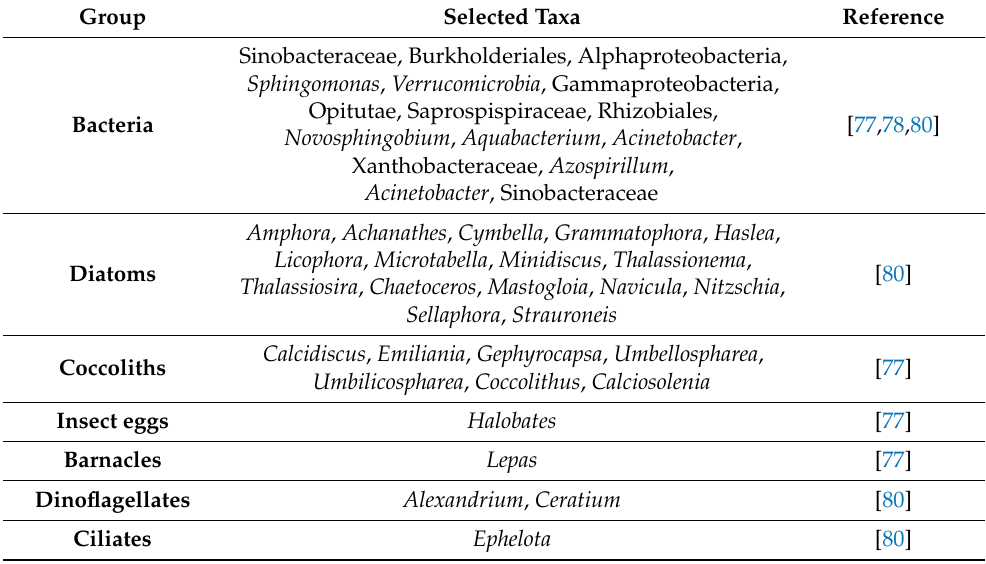
Table 1. Selected microorganisms present on the MP surface (>5